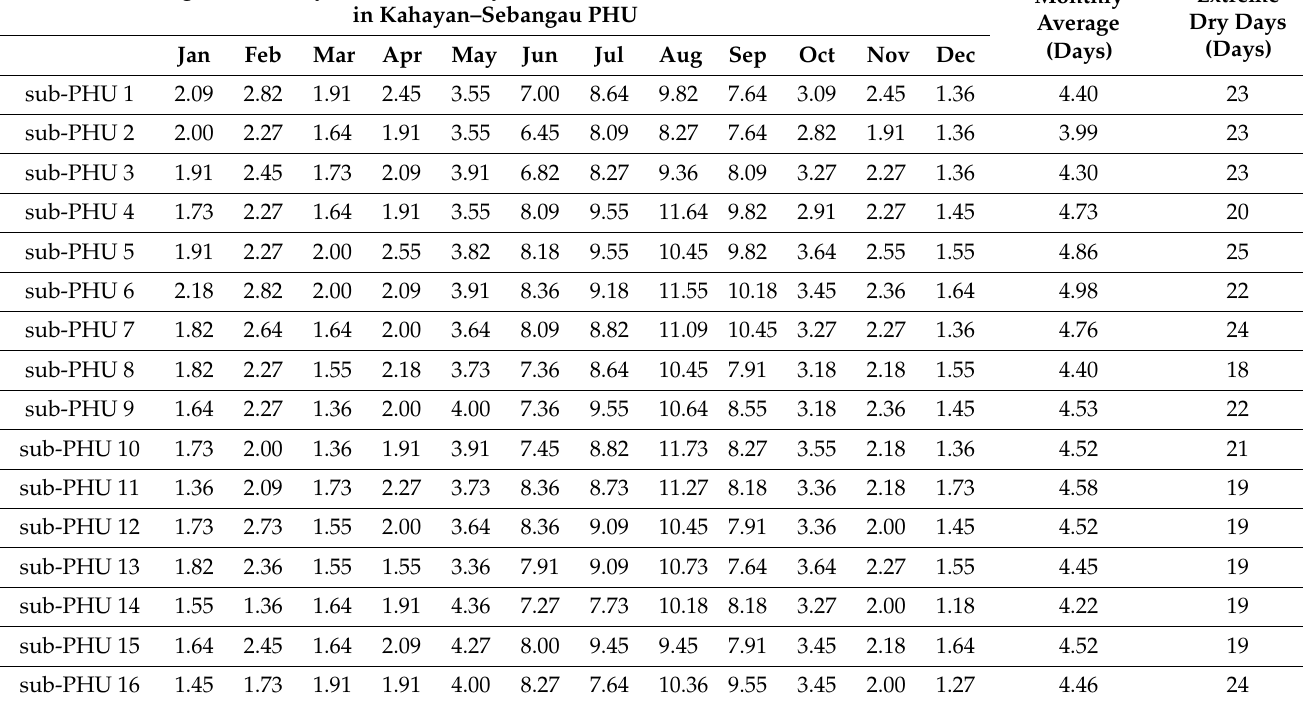
Table 3. Average longest dry period within each month (where precipitation = 0 mm/day) for each sub-PHU in 2010–2020 (data source: CHIRPS using Google Earth Engine; processed by the